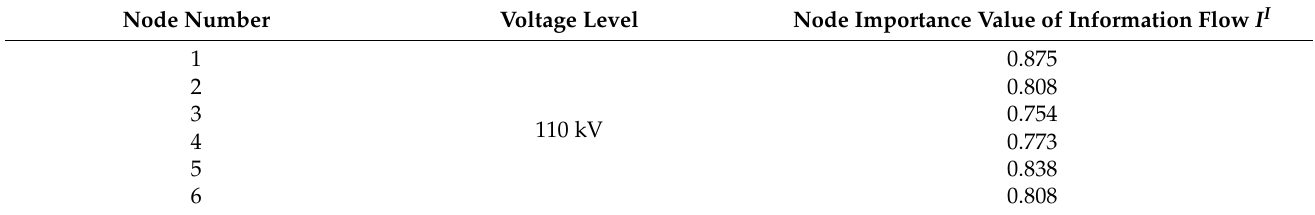
Table 9. Node importance value of information flow.